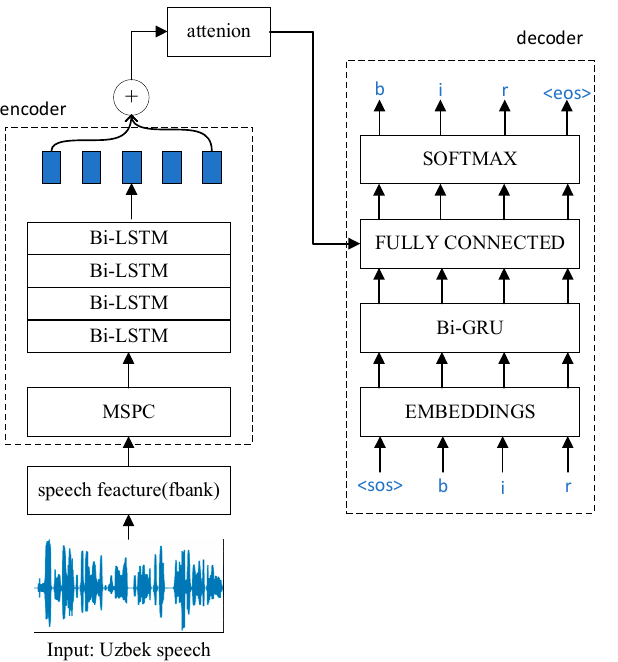
Figure 5. Encoder–decoder with attention model architecture for ASR. The model of input is the Uzbek speech utterance bir. <SOS> and <EOS> represent the start and the end of a sentence, respec- tively.